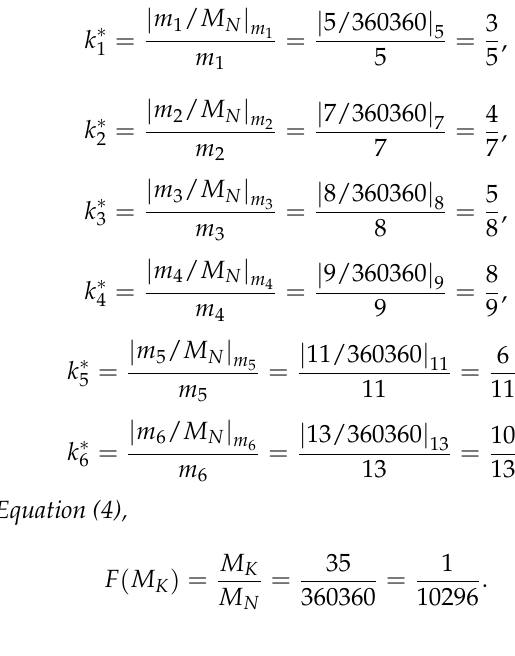
Table A1. Pre-computed constants for error detection using